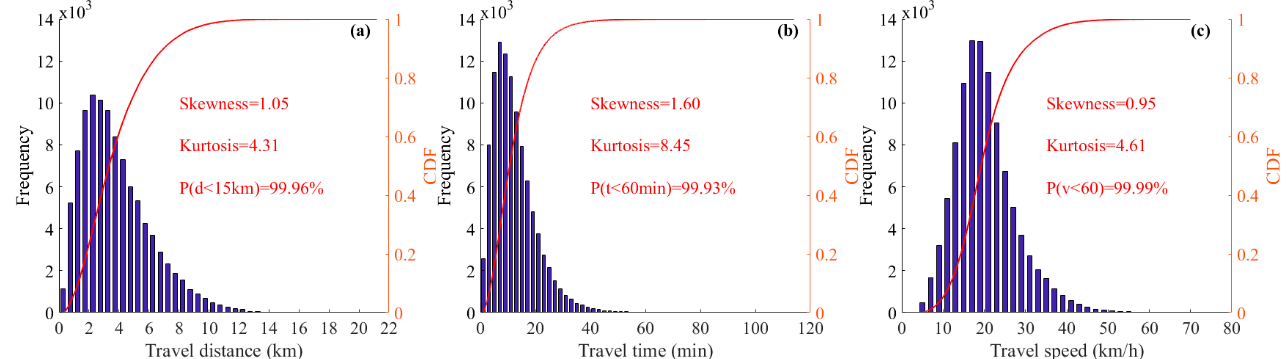
Figure 2. Distribution of trip metrics on Thursday, November 3, 2016: ( a ) distribution of travel distance; ( b ) distribution of travel time; and ( c ) distribution of travel speed.